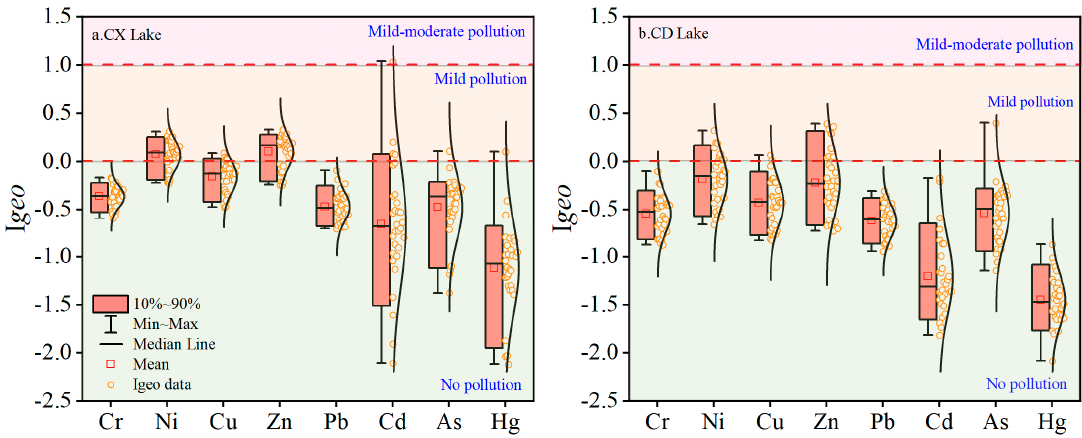
Figure 3. Boxplots of I geo of heavy metals in sediments. ( a ) Chengxi Lake; ( b ) Chengdong Lake. In the sediments of Chengxi Lake and Chengdong Lake, 51.67%, 11.67%, 50%, 5.0%, 3.33%, and 1.67% of the sample points of Ni, Cu, Zn, Cd, As, and Hg were in a moderately